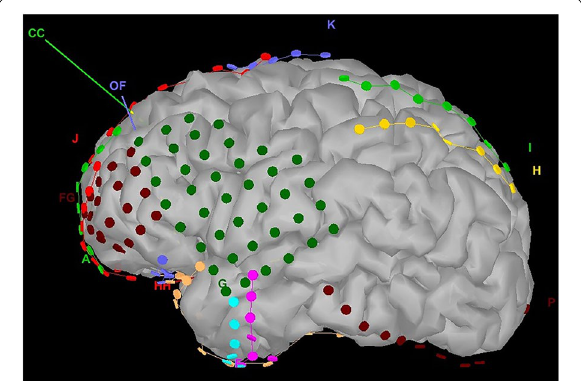
Fig. 1 Reconstruction of electrodes on a mesh of a preimplantation 3-D reconstruction of the patient’s own MRI (case